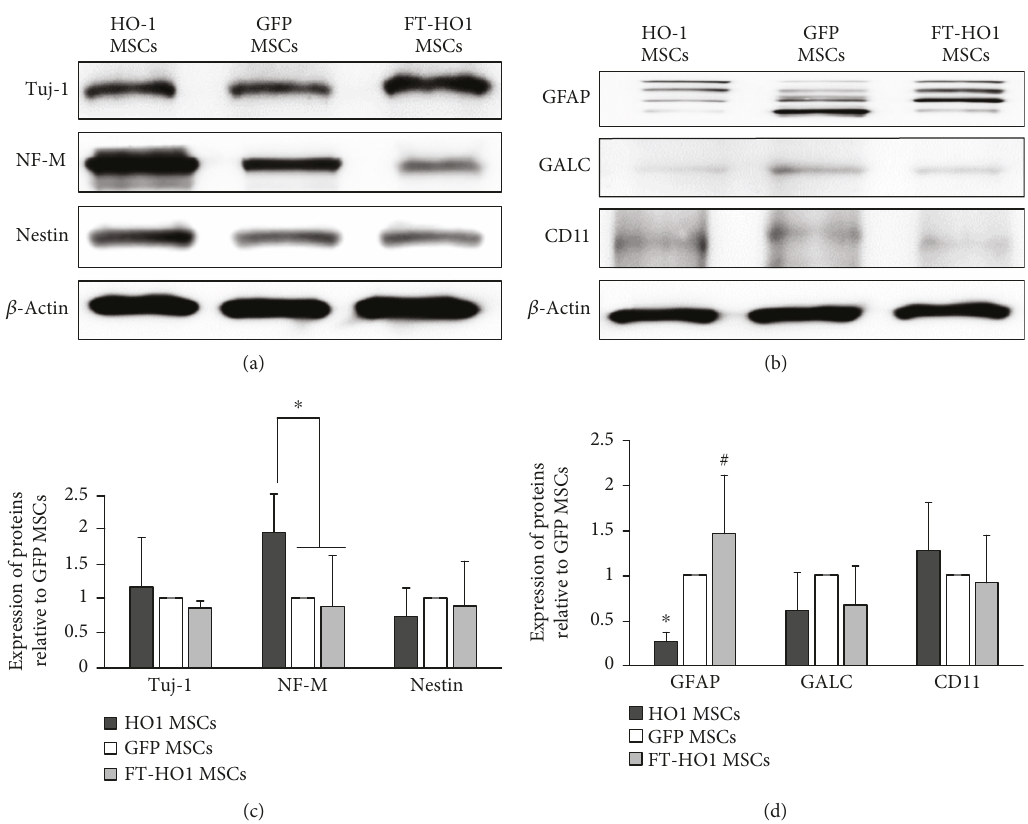
Figure 5: Expression of neural and glial cell markers. (a) Representative densities of neural markers. (b) Representative densities of astroglial cell markers. (c, d) Quantitative analysis of densities obtained for neural and astroglial cell markers relative to GFP MSCs. Each bar represents the average of 4 samples in a group and error bars represent standard error. ∗ and # indicate signi fi cance at p ≤ 0 05